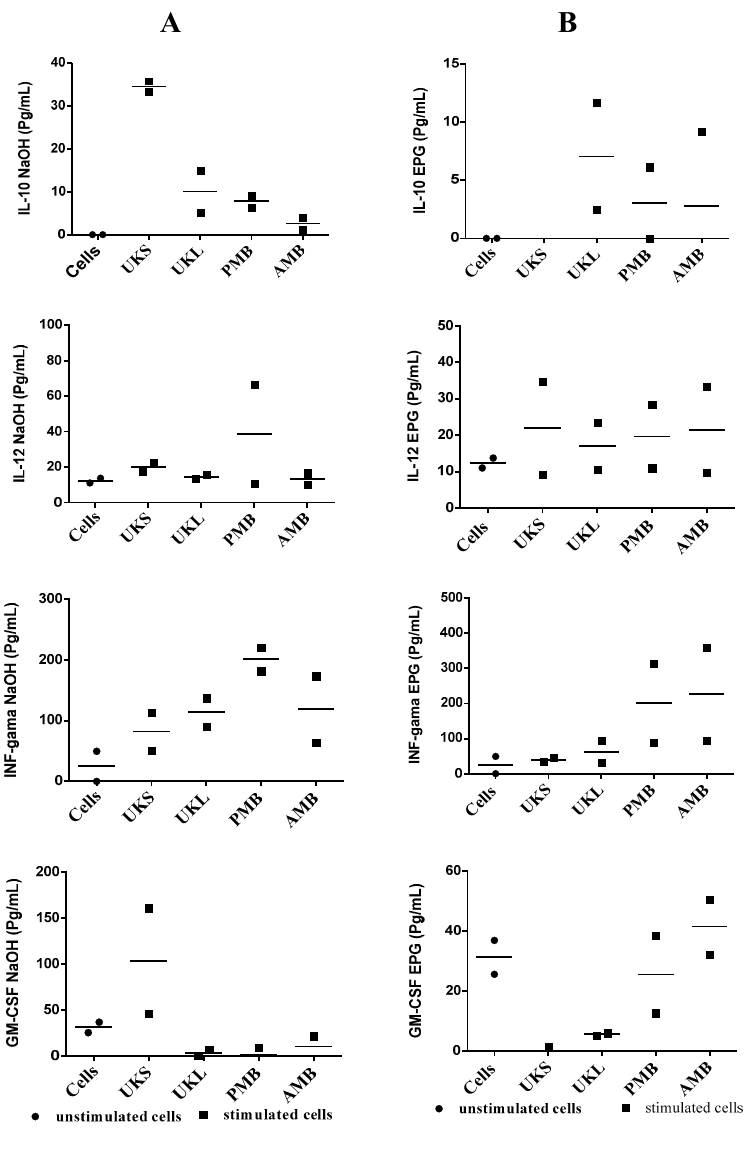
Figure 6. Representative dot scatter of the profile of cytokine induction by PMBCs of two volunteers after stimulation by saponified oxalate extracts (oxa + NaOH). ( A ) Oxalate extracts digested by EPG; ( B ) from plants (UKS, UKL, AMB) compared to unstimulated cells. A